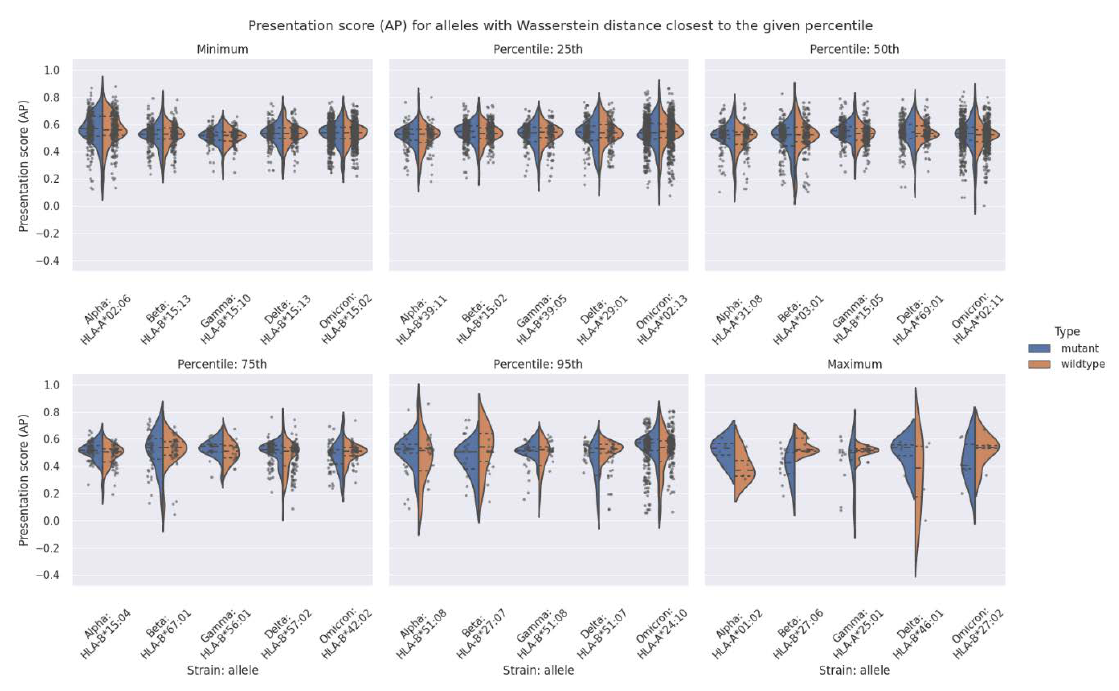
Figure 3. Violin plots of the AP score distribution for the mutant and wildtype peptides for the HLA alleles with a Wasserstein distance closest to the minimum, maximum, or given percentile of all the Wasserstein distances for that VOC. The dashed lines within each violin represent the quartiles and the dots show the AP for each peptide. Table 4. Top three HLA alleles that present the biggest Wasserstein distance for each of the VOC and their corresponding haplotype according to The Allele Frequency Net Database (AFND). The last column shows in which populations the set of HLA alleles is presented with the highest frequency. For the cells denoted by an * it means that the AFND database only provided results for one of the top three most affected HLA